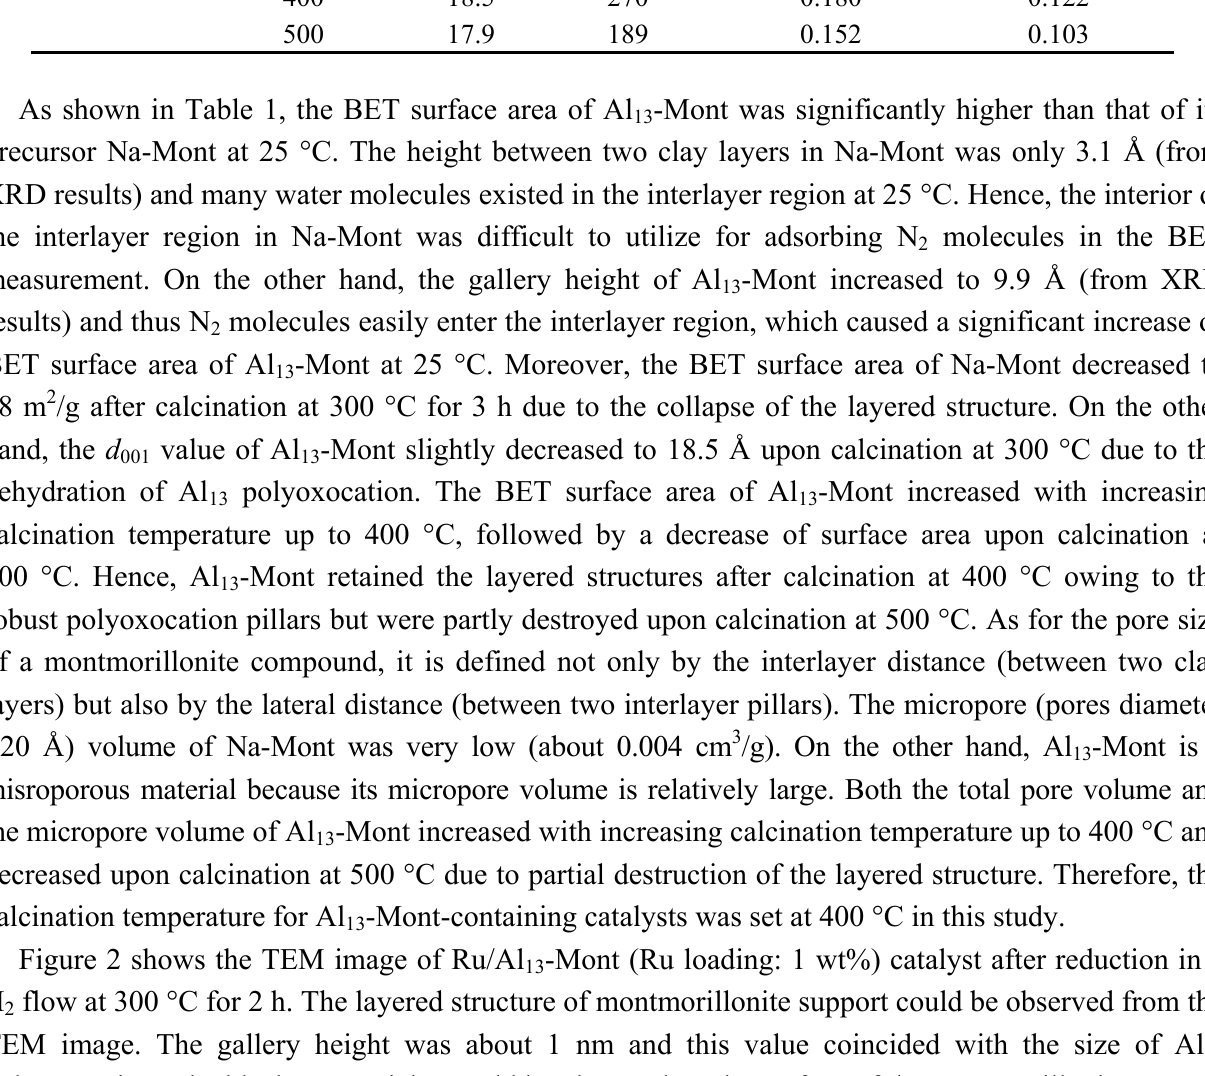
Table 1. Basic characteristics of raw montmorillonite and its Al